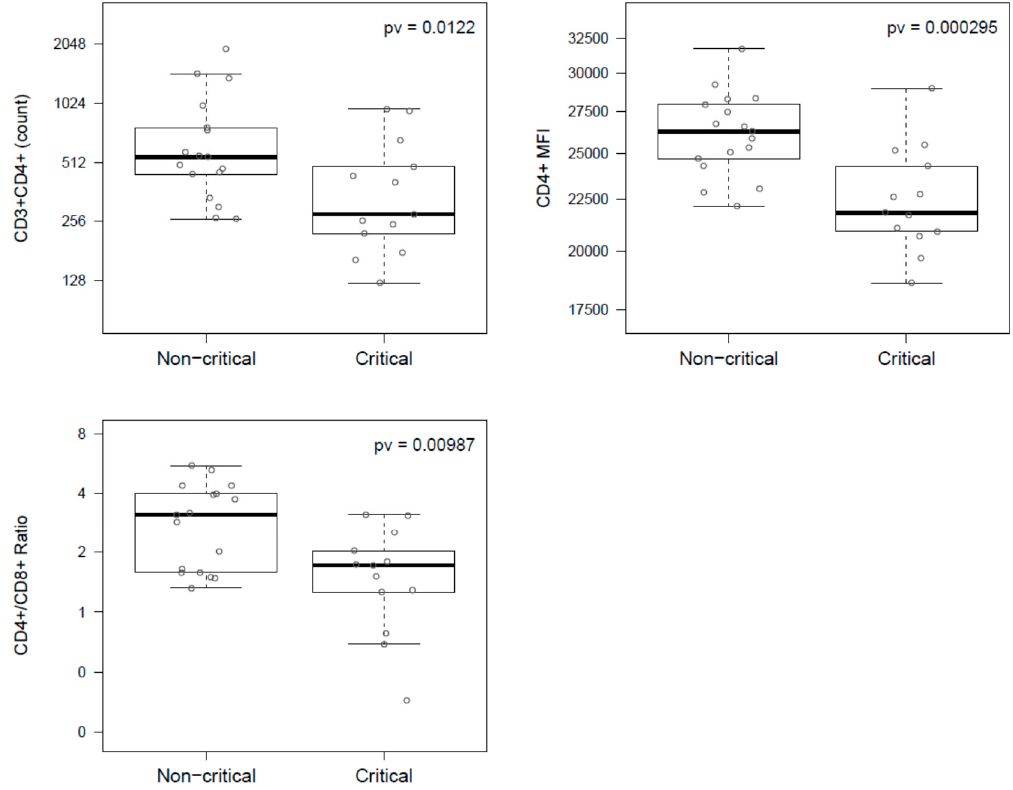
Figure 1. Boxplot showing association of CD3 + CD4 + count (top-left), CD4 + MFI (top-right), and CD4 +/ CD8 + ratio (bottom-left) with COVID-19 evolution. p -values were derived from the F-test of a linear model. Table 2. Association of blood determinations with COVID-19 evolution after statistical control by age, gender, and time from symptoms onset.